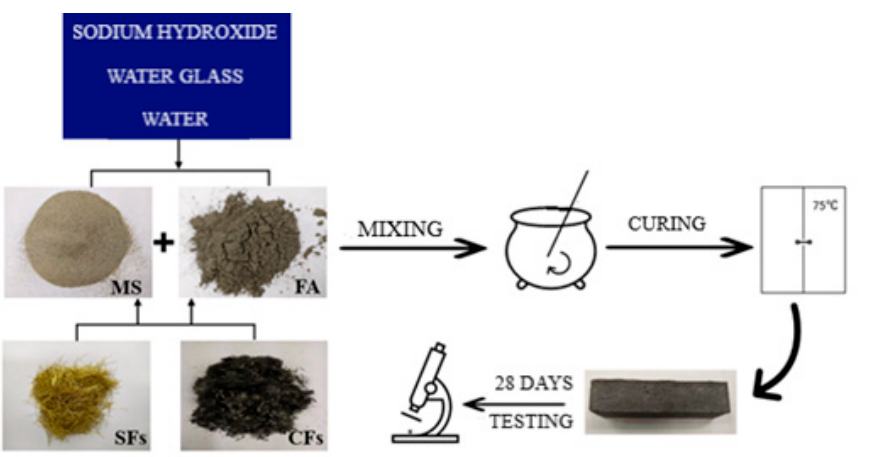
Figure 5. Scheme for the preparation of samples.